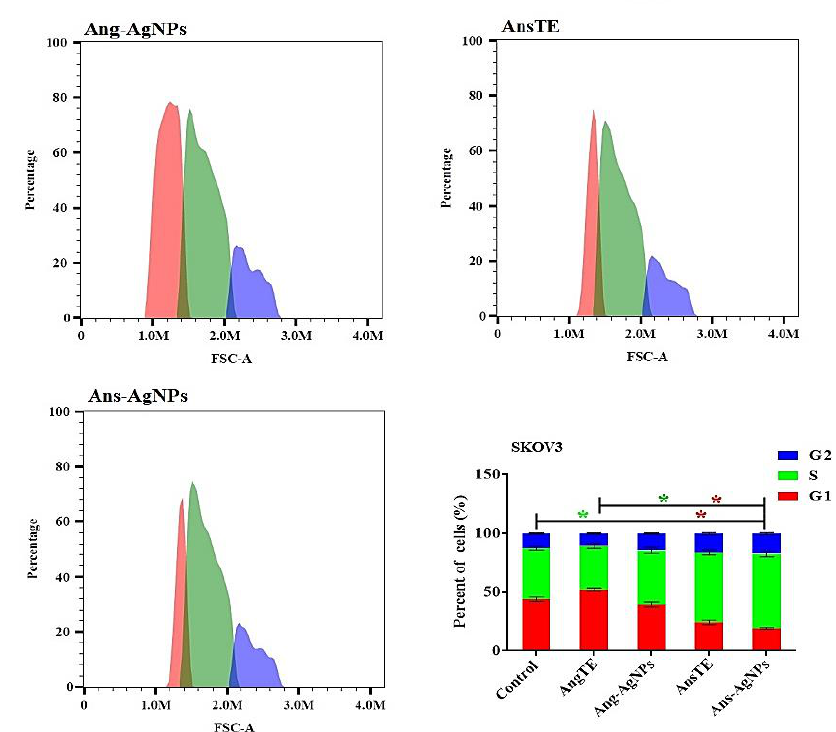
Figure 10. Effect of the extracts, AngTE, AnsTE, and their nanoparticles, Ang-AgNPs, and Ans- AgNPs, respectively, on cell cycle distributions of SKOV3 cells. Cell cycle distribution was determined using DNA cytometry analysis after exposure to AngTE, Ang-AgNPs, AnsTE, and Ans-AgNPs for 48 h. Data are presented as the mean ± SD; n = 3; G1, G2 and S are cell cycle phases, One-way ANOVA was used to test for statistical difference (* p < 0.05).